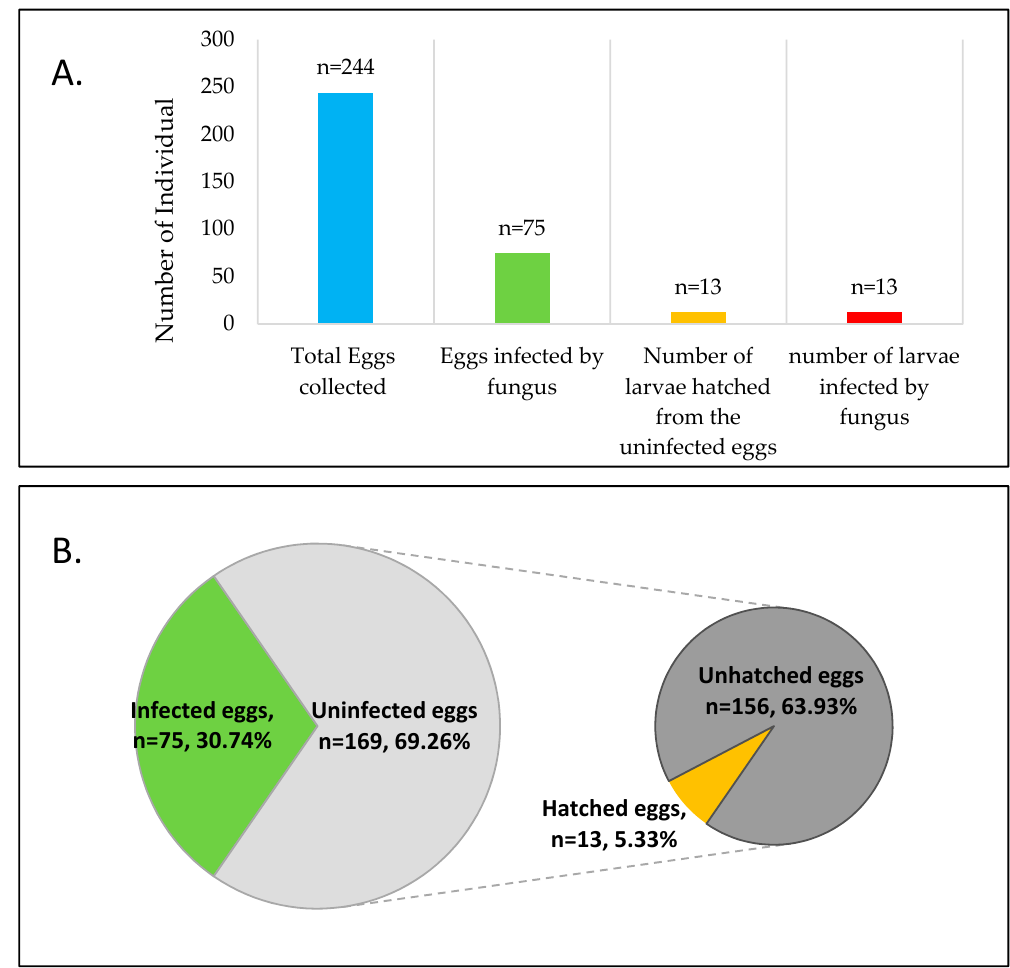
Figure 1. Number of infected eggs and larvae in contrast with the total number of eggs and larvae hatched from the eggs. ( A ) Total of 244 eggs were collected from 40 different matings, representing 120 males and 80 females in individual petri dish in 3:2 ratio. There were 75 eggs infected by fungi and 13 larvae hatched from 169 uninfected eggs. ( B ) The fungus infection rate was 30.74%, while the hatching rate of the uninfected eggs was 5.33%.